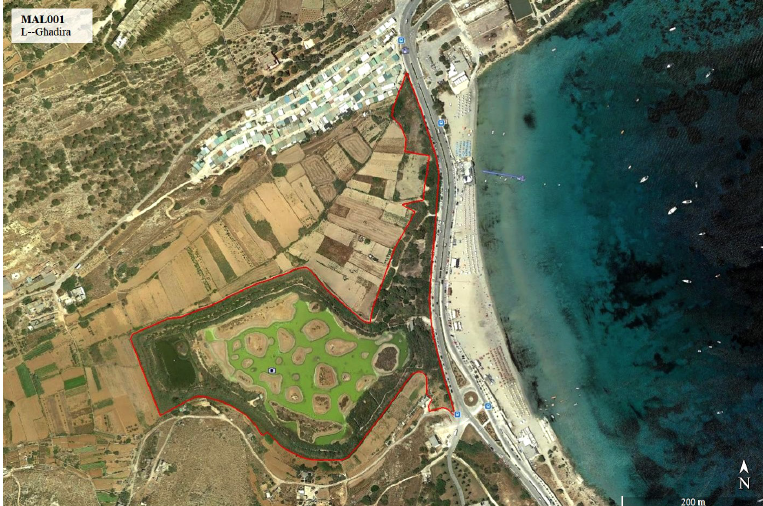
Figure 3. L-Inħawi tal-Għadira Nature Reserve (MAL001) (source : Nature Trust – FEE Malta,